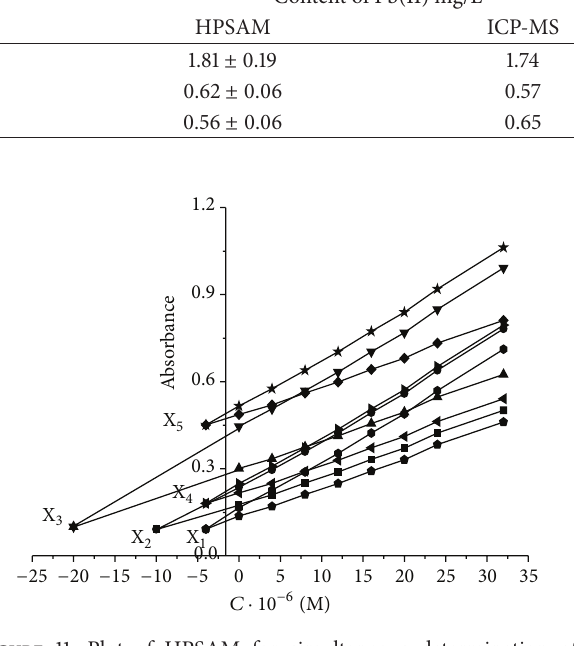
Figure 11: Plot of HPSAM for simultaneous determination of Cr(III) and Pb(II) ion in various mixtures: X 1 , X 2 , and X 3 (constant concentration of Pb(II) ion and various concentration of Cr(III)) and X 4 and X 5 (constant concentration of Cr(III) ion and various concentration of